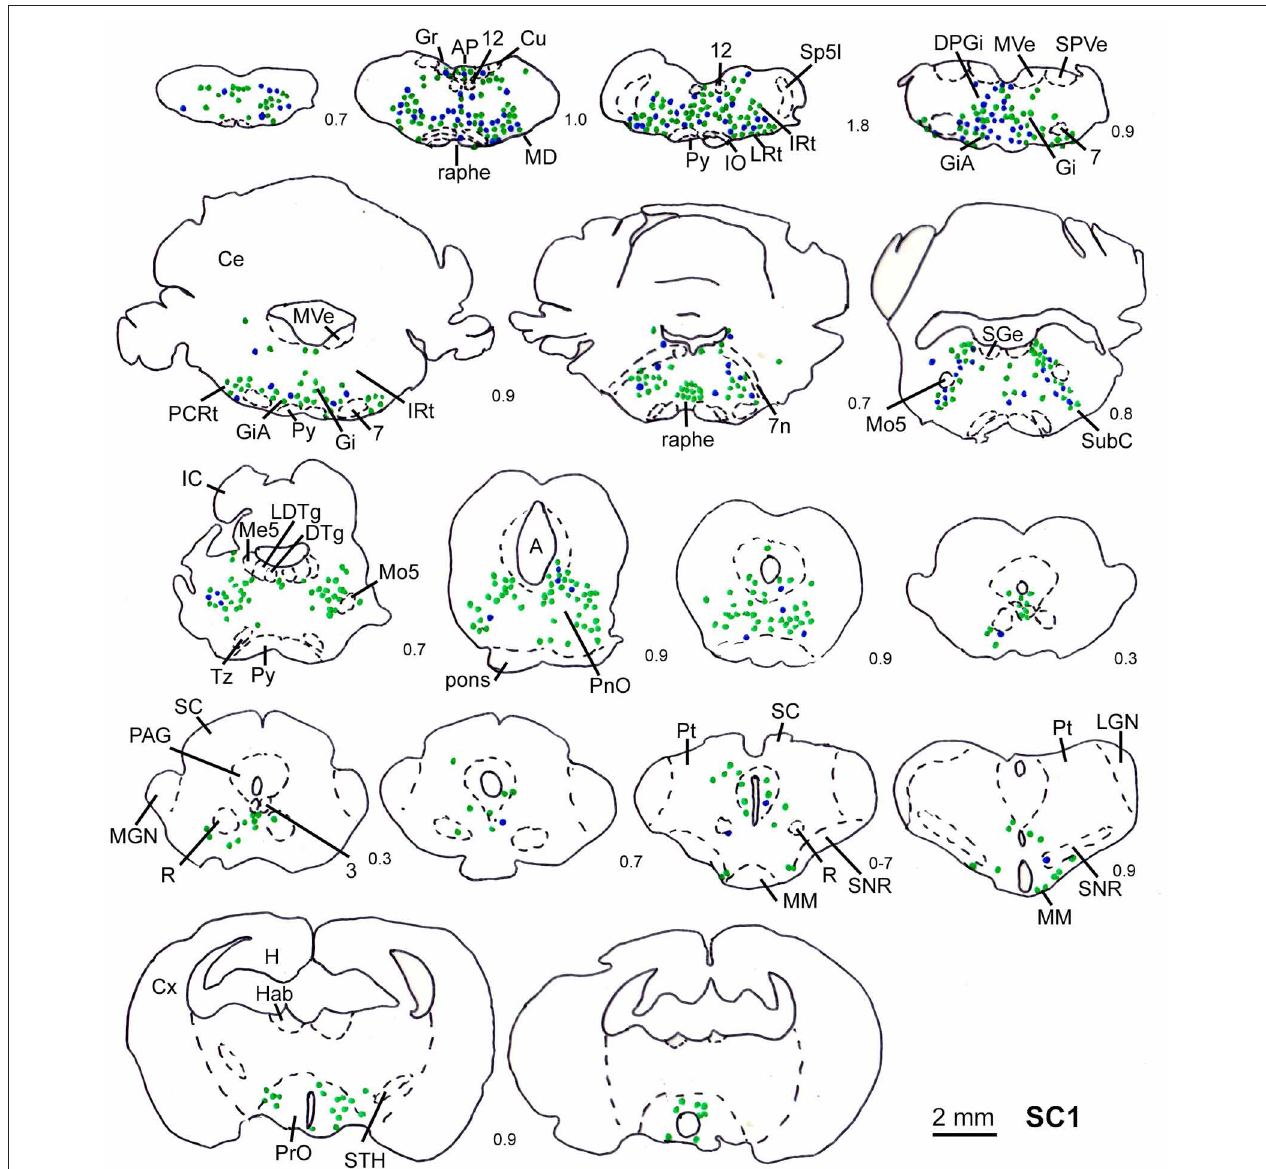
FIGURE 3 | Series of frontal sections through the brainstem and midbrain of rat SC1 demonstrating retrogradely labeled neurons after inoculation of the m. trapezius after a survival time of 80.3h. The sections are arranged from posterior (upper left) to anterior (lower right), the